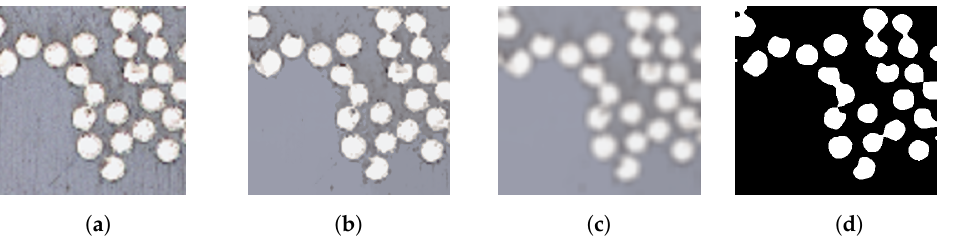
Figure 3. Image analysis techniques applied to a micrograph section: ( a ) original image, ( b ) mean shift segmentation, ( c ) blurring step and ( d ) thresholding